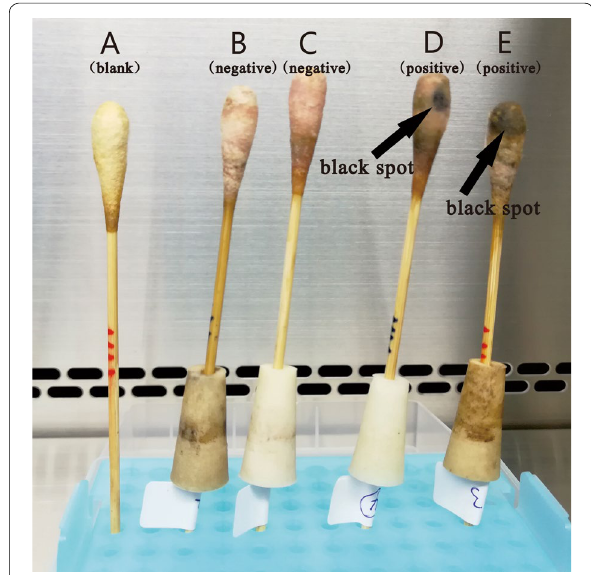
Fig. 4 Visual observation of the whole-sample solid-phase enrichment assay using the optimized H 2 S-producing medium: a prepared swab with no sample applied, b , c negative control (swabs with E. coli only), d , e swabs applied with 10 1 cells of Salmonella and 10 5 cells of E. coli